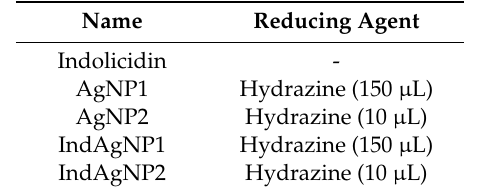
Table 1. Indolicidin and AgNPs prepared using di ff erent amount of N 2 H 4 · H 2 O.